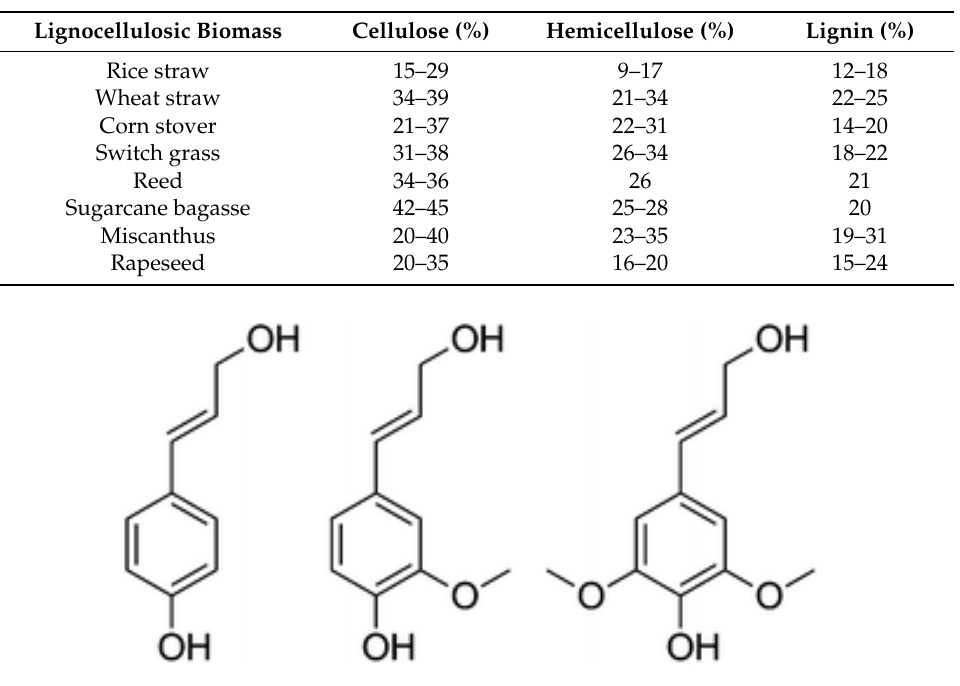
Figure 4. Lignin polymer unit (coumaryl, Coniferyl, and sinapyl alcohol).